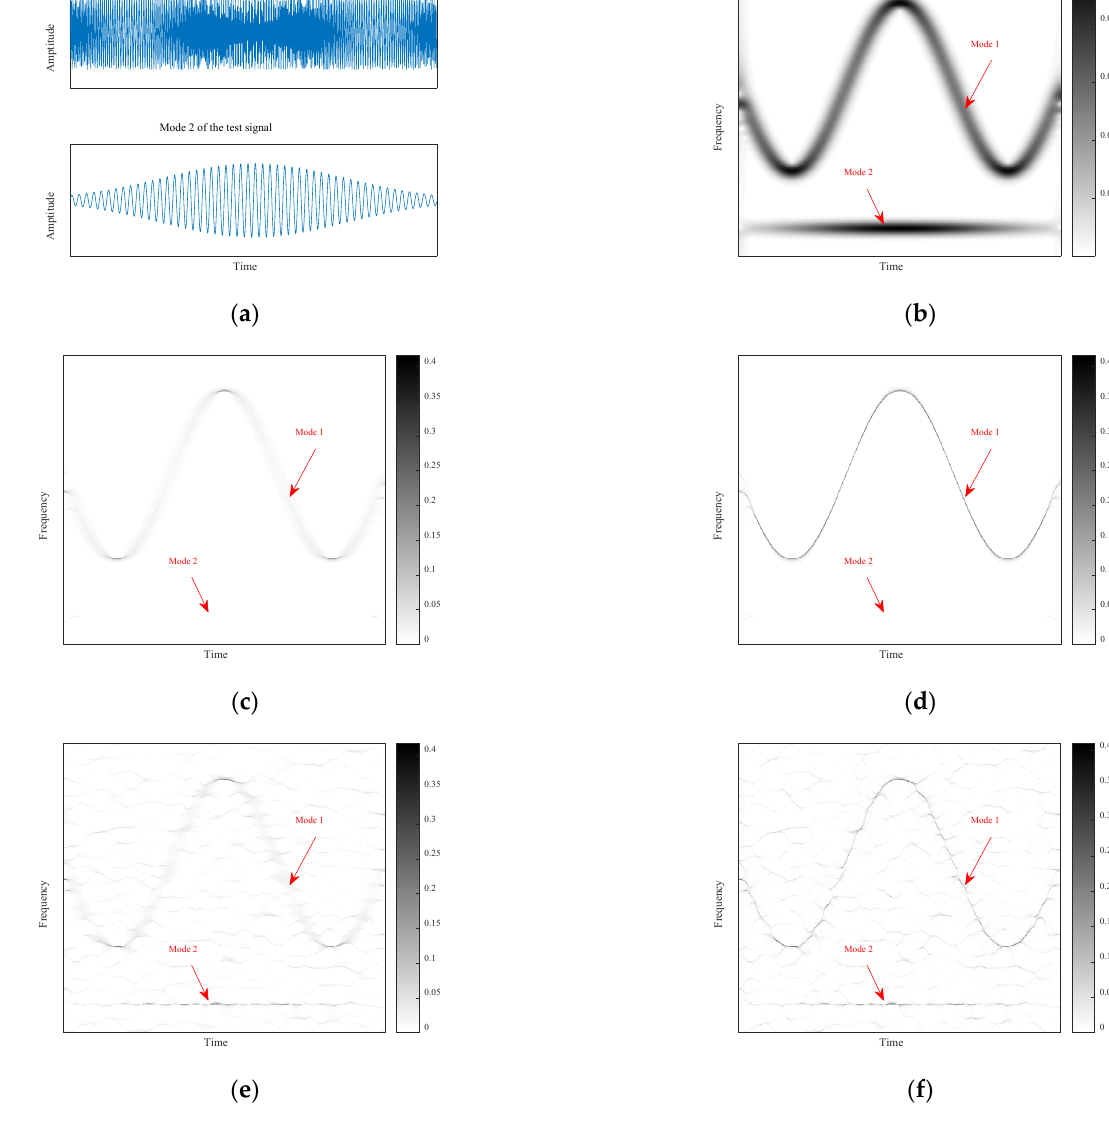
Figure 3. Comparison of short-time Fourier transform (STFT), first-order synchro-squeezing transform (SST) and second- order SST: ( a ) time-domain diagrams of the test signal which contains two modes; STFT result ( b ), first-order SST result ( c ) and second-order SST result ( d ) of the clean signal; first-order SST result ( e ) and second-order SST result ( f ) of the noisy signal with SNR of 5dB.